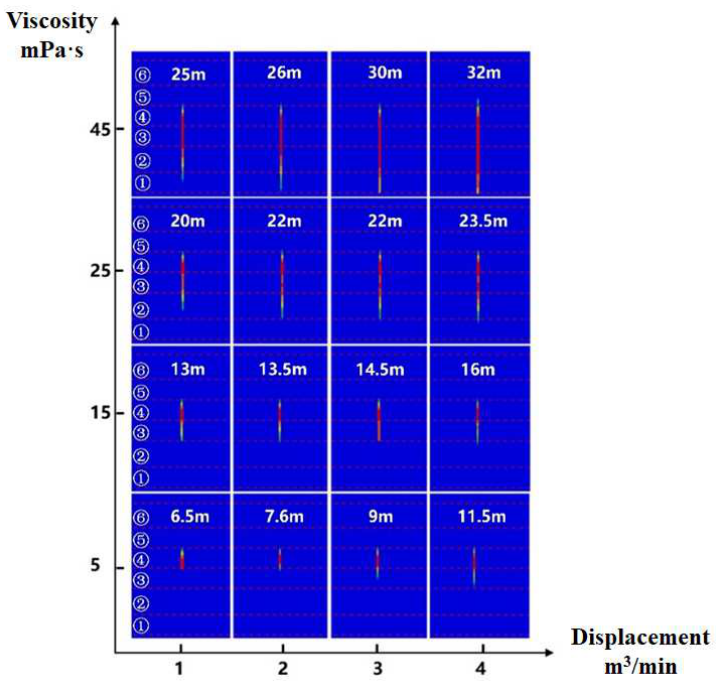
Figure 7. Example well simulation results. Table 6. The main rock mechanics parameters of the example well.